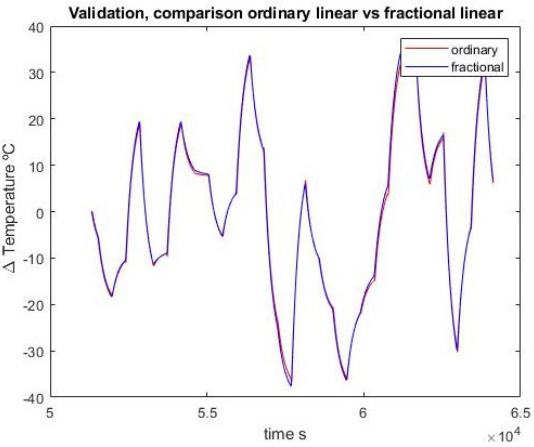
Figure 15. Second-order models comparison with validation